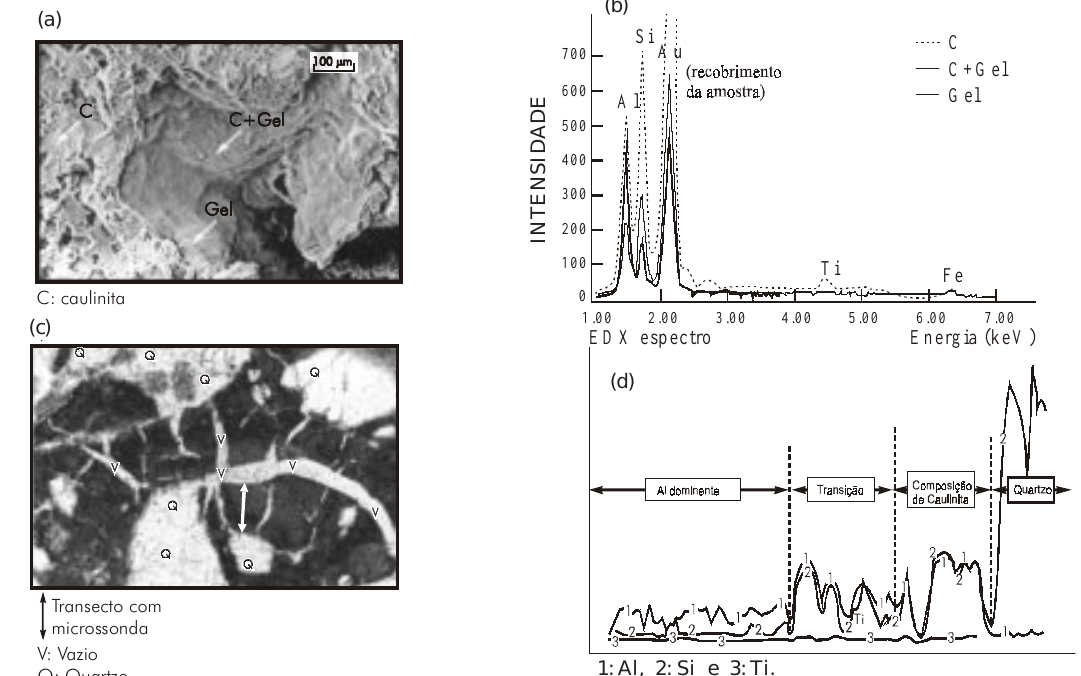
Figura 4. Imagem do fragipã amarelo-claro em Microscópio Eletrônico de Varredura (a) com seu respectivo espectro de microssonda (b) e fotomicrografia de uma banda ferruginosa da depressão D3 (c) com o transecto com microssonda de um gel fendilhado na borda de um vazio